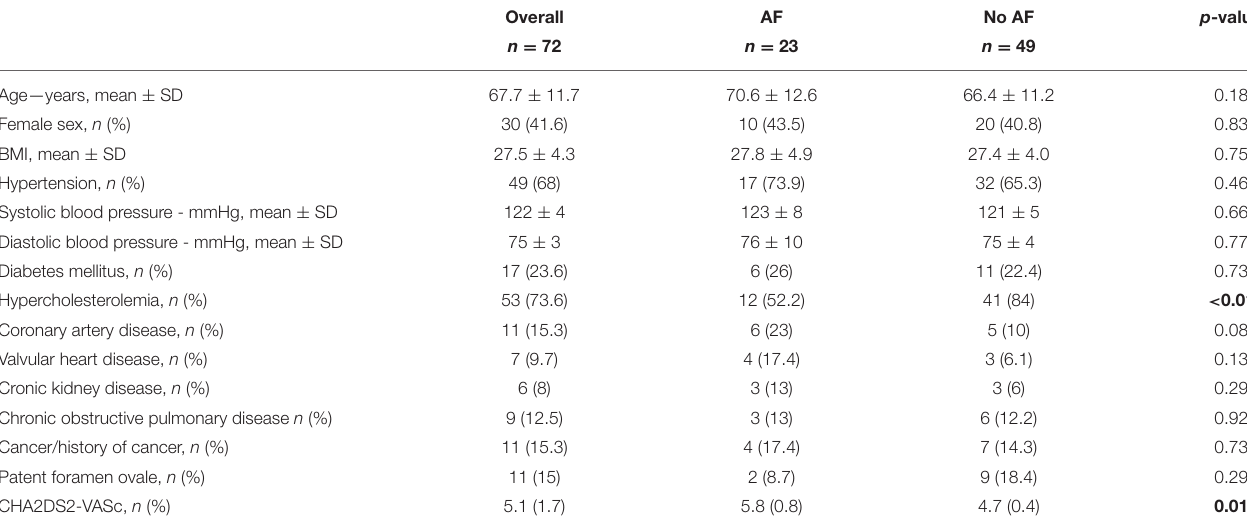
TABLE 1 | Demographic and clinical characteristics in the overall population and according to the occurrence of AF. Overall AF No AF p -value